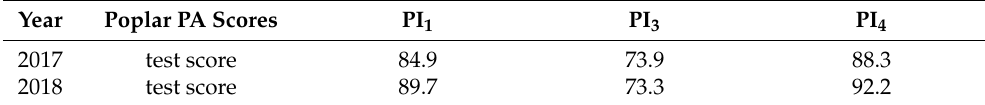
Table A4. Poplar PA scores achieved with the ten best feature subsets based on SFFS in the single- feature configuration using the three variants of the poplar index: PI 1 , PI 3 , and PI 4 . The test score gives the poplar PA after prediction on the test set (50% of reference data). These values are significantly lower than the best PA scores obtained with PI 2 : 92% in 2017 and 95% in 2018 (see Table 4 in the core of the manuscript).